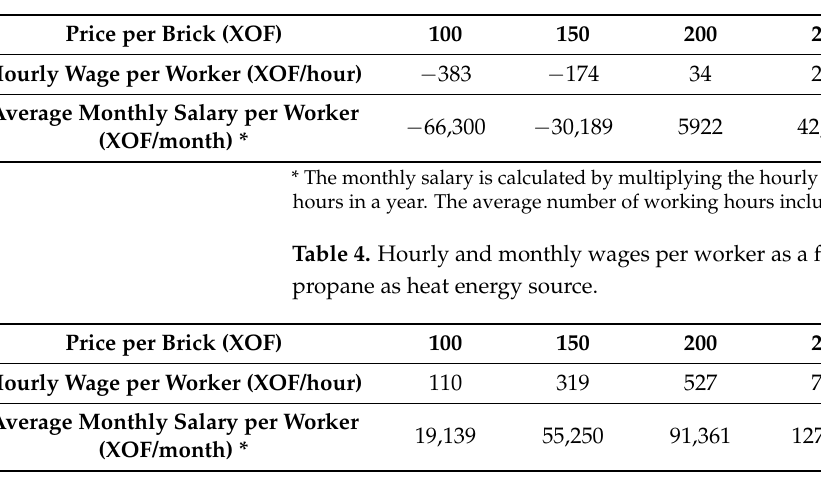
Table 3. Hourly and monthly wages per worker as a function of manufactured price per brick using charcoal as energy source.